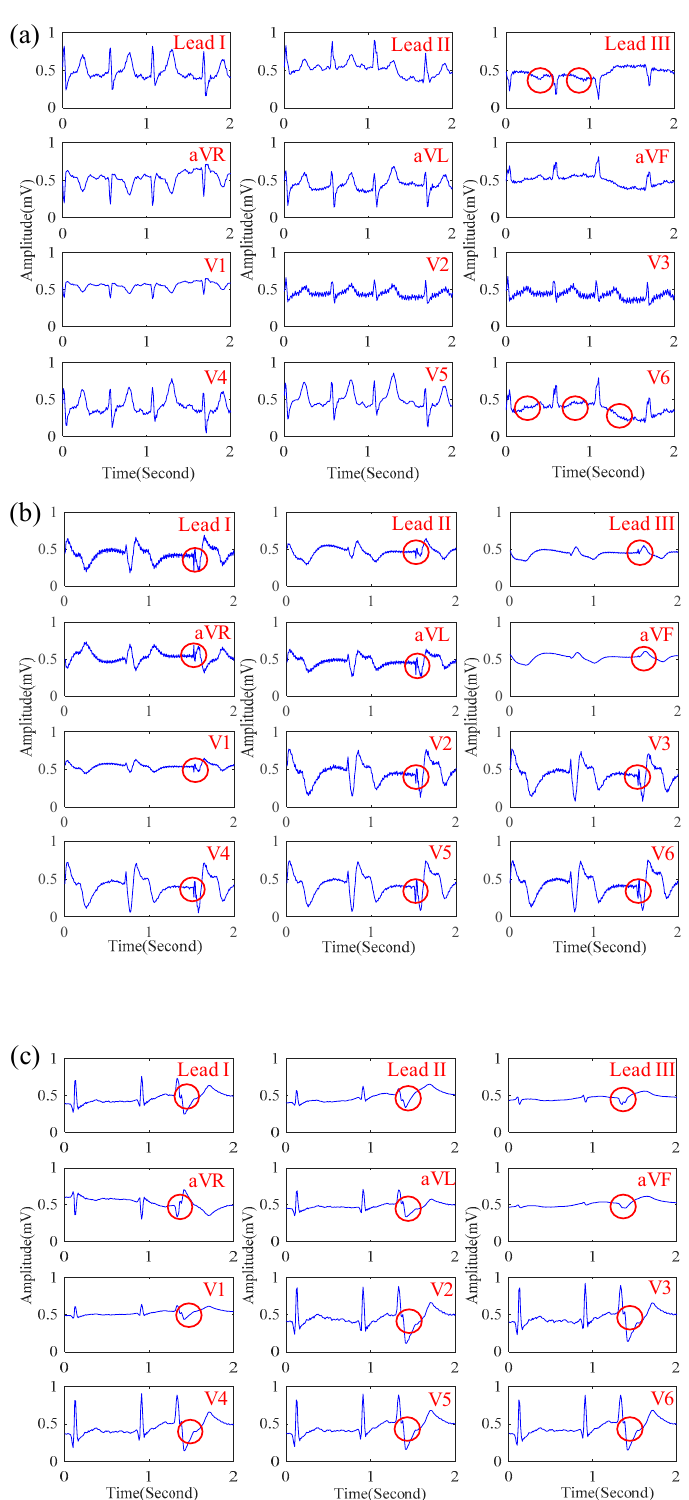
Figure 8. The ECG signal of patients with ( a ) myocardial infarction, ( b ) installation pacemaker, and ( c ) ventricular premature contraction obtained by the proposed system.